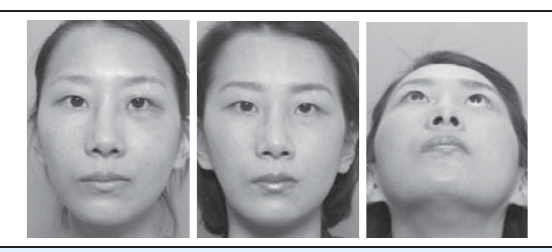
Figure 7. Postoperative view at two weeks and six month after